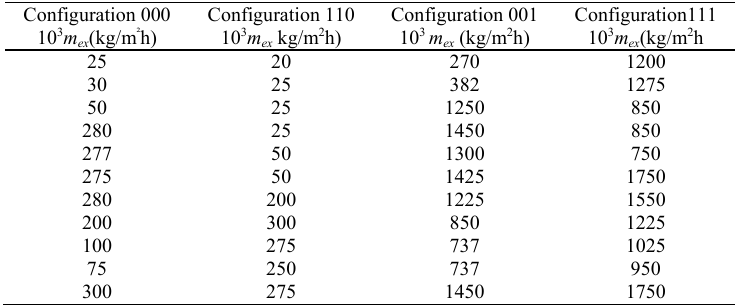
Table 4 Square root of mean deviation ( e ) and coefficient of linear correlation ( r ) for the four models Table 4. Square root of mean deviation (e) and coefficient of linear correlation (r) for the four Configuration